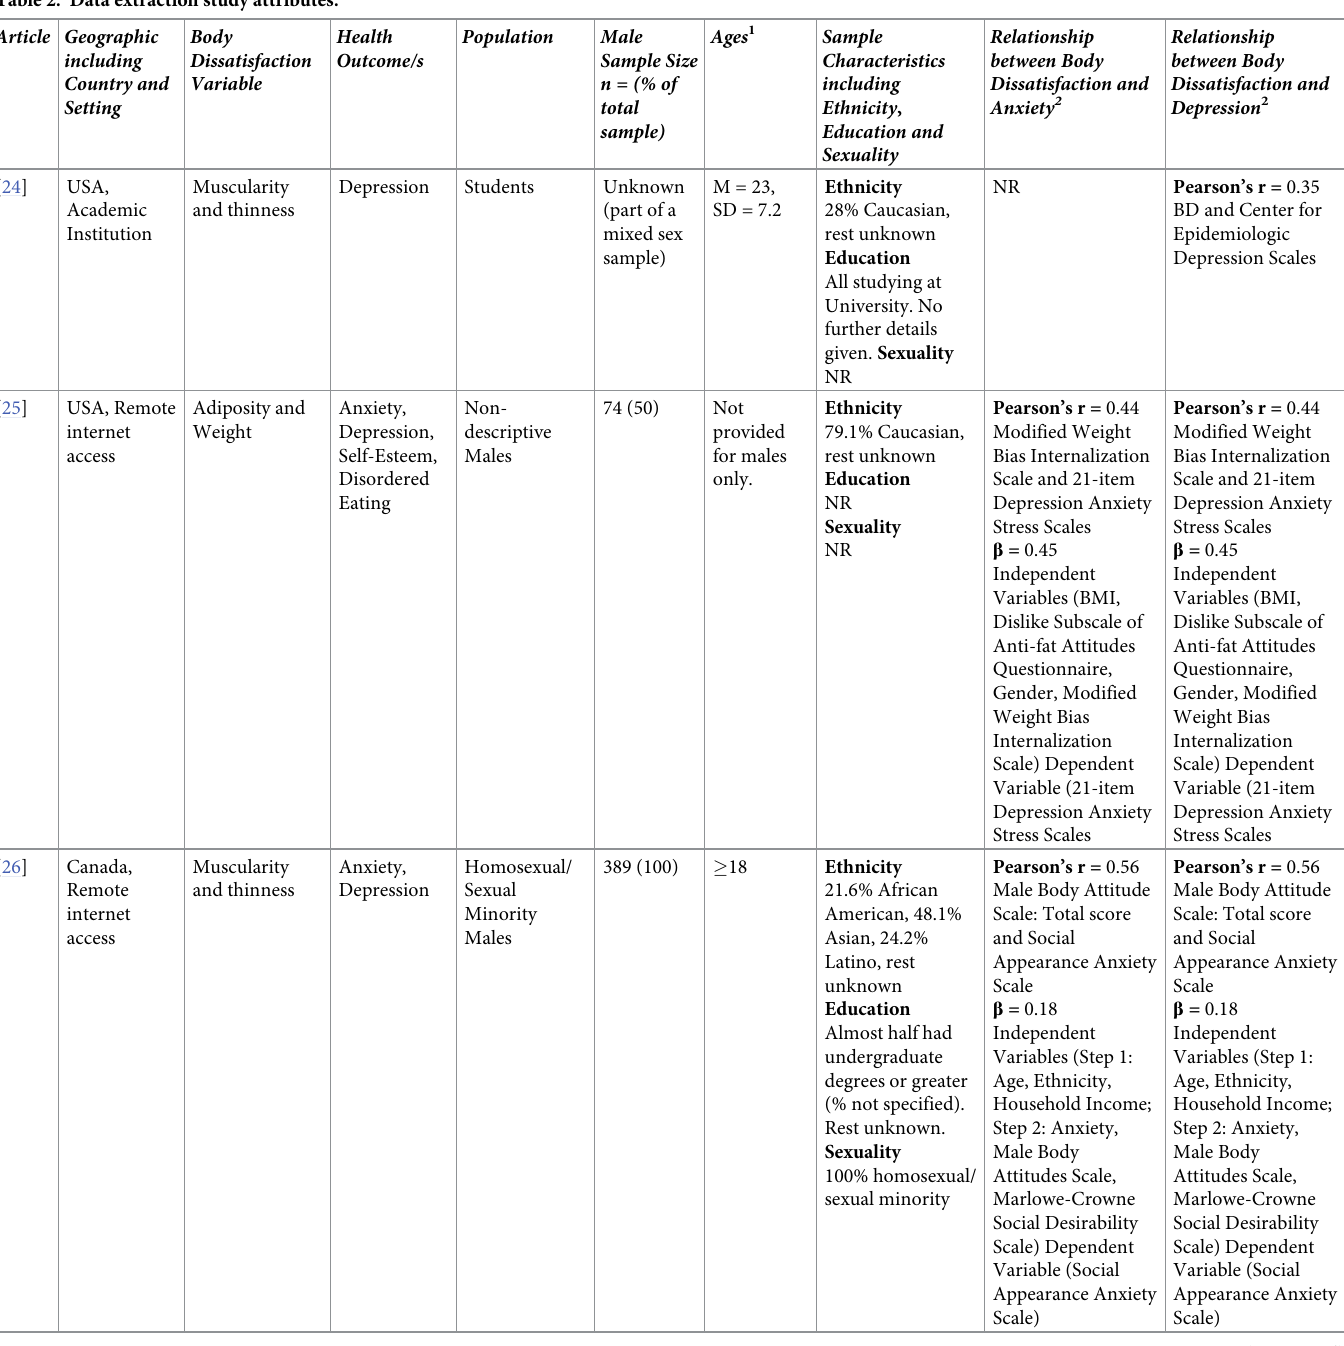
Table 2. Data extraction study